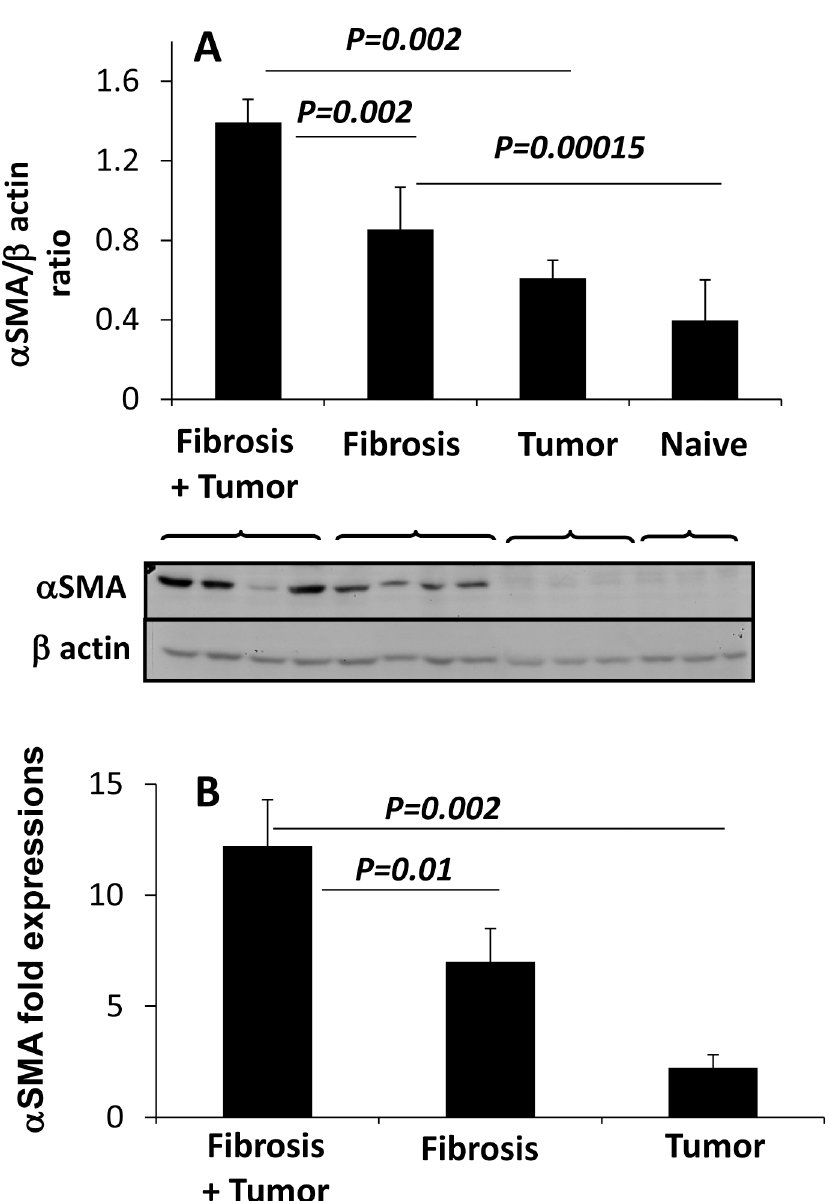
Fig 3. Tumor increase severity of hepatic fibrosis. Fibrotic profile was estimated by (A) Western blot quantitations and (B) RT-PCR expressions of α smooth muscle actin ( α SMA). (A) (Lower panel) displays a representative membrane with examples of α SMA expression as a marker for the HSCs activation (upper bands) and GAPDH (lower bands) expression by western blotting in the harvested liver protein extracts. (A) (Upper panel) shows the calculated ratio of α SMA/ β -actin based on the densitometry readings of the bands. (B) Real-time PCR data reflect changes in gene expression of α SMA mRNA expressed as fold change compared with na ï ve mice. Expression of α SMA mRNA corresponded to the western blot results. Experiments were repeated 4 times, in each time 4 mice were included in each group. Averages of the 4 experiments were included in the quantitations of western blots and RT